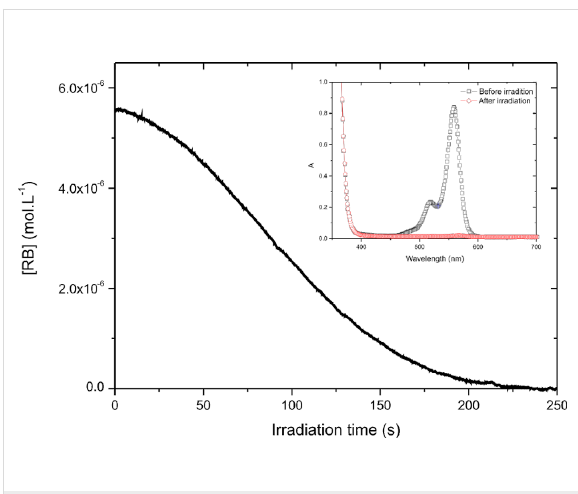
Figure 2: Evolution of [RB]( t ) in the photocyclic system RB/TA/EDB as a function of irradiation time ( λ = 532 nm, 9 mW·cm − 3 ). Insert: absorp- tion spectra obtained before and after